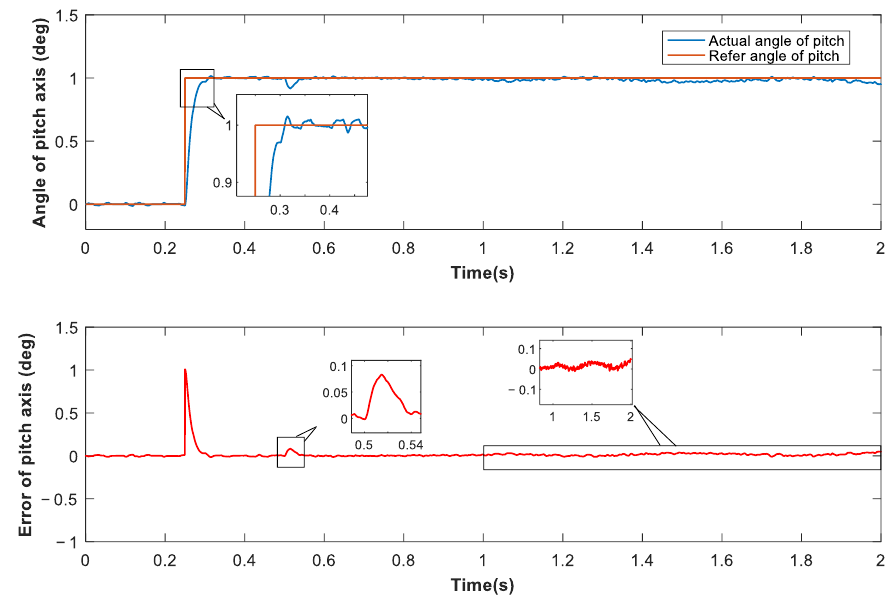
Figure 9. Response of pitch axis with cross-feedback module under CMAC-SMC control.